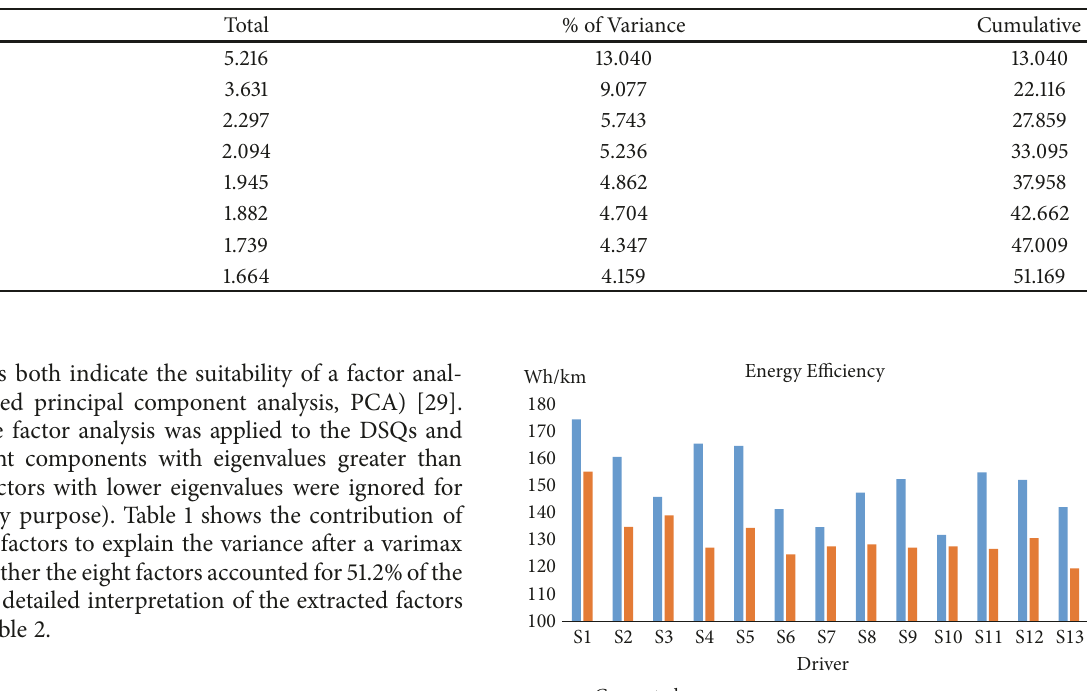
Figure 3: Demographic information of DSQ respondents. Table 1: Variance explained by each factor.